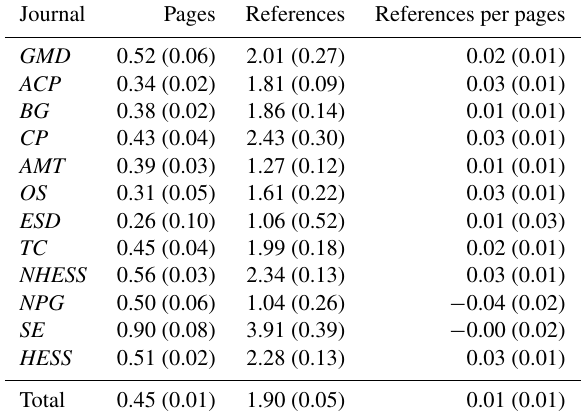
Table 2. Linear fit of the temporal trends of pages, references and references per page for different EGU journals for all analysed pa- pers between 2010 and 2020. The numbers inside the parentheses are the standard deviations of the estimated time trends (slope of the linear fit). The units are in yr − 1